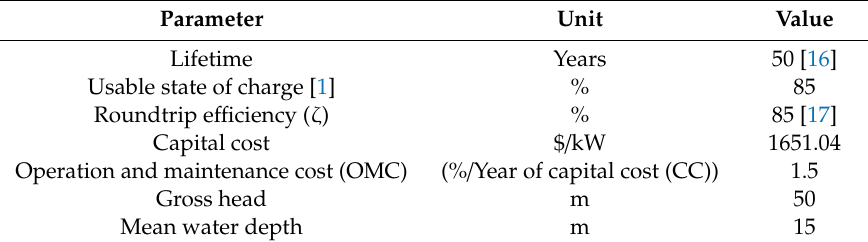
Table 1. Values of parameters used for the pumped hydro storage (PHS)